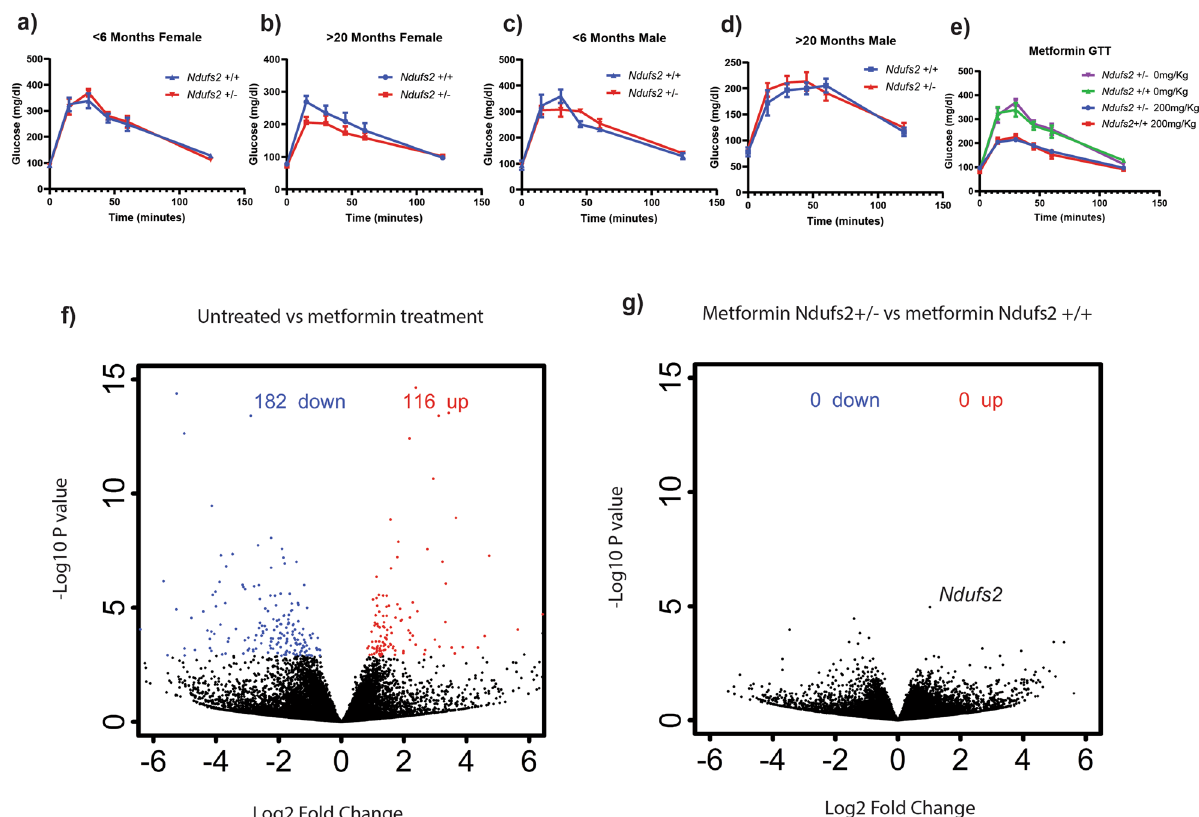
Figure 4. Ndufs2 hemizygosity minimally impacts organismal responses to acute metformin treatment. ( a – d ) Multiple t-tests, one per time point Ndufs2 + / + vs NDUFS2 + / − discovery determined using the Two-stage linear step-up procedure of Benjamini, Krieger and Yekutieli, with Q = 0.05%. Each row was analyzed individually, without assuming a consistent SD. No discoveries. Error bars represent standard error. ( a ) Glucose tolerance test for females < 6 months of age n = 4–6. ( b ) Glucose tolerance test females > 20 months of age n = 7–11 per group ( c ) Glucose tolerance test for males < 6 months of age n = 2–3 per group. ( d ) Glucose tolerance tests for males > 20 months of age n = 5–7. ( e ) Oral glucose tolerance test (GTT) with or without 30-min pre-treatment with 200 mg/Kg metformin in Ndufs2 +/+ and Ndufs2 +/− mice. Ordinary one-way ANOVA p = 0.4275, Sidak’s multiple comparisons tests by genotype not significant. n = 4–8. Error bars represent standard error. ( f ) Liver tissue differential gene expression analysis from untreated Ndufs2 + / + mice versus Ndufs2 + / − mice 8 h after treatment with 200 mg/Kg metformin. Volcano plot individual gene FDR cutoff 0.05. n = 3,5. ( g ) Liver tissue differential gene expression analysis after 8 h of treatment with 200 mg/Kg metformin in Ndufs2 + / + vs. Ndufs2 +/− mice. Volcano plot individual gene FDR cutoff 0.05. n =